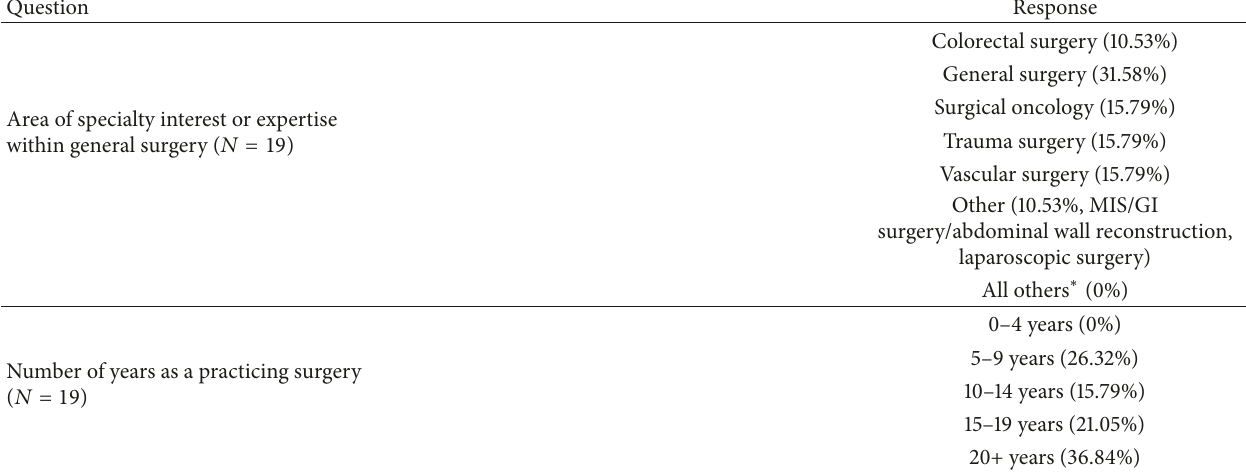
Table 2: Program director